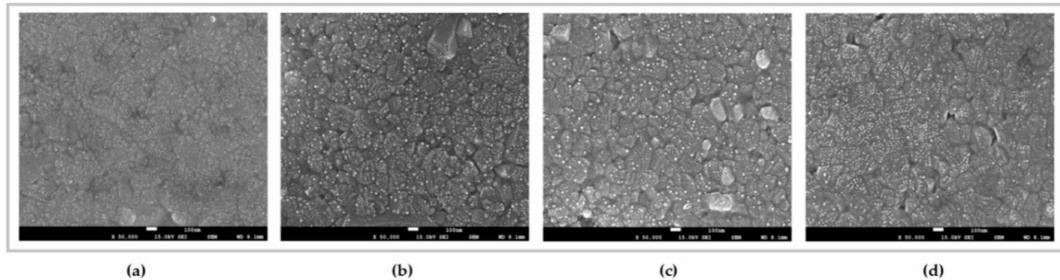
Figure 7. SEM images of the 0.1 wt.% Dy 2 O 3 -doped 0.98BaTiO 3 -0.02(Ba 0.5 Ca 0.5 )SiO 3 specimens sintered at 1320 ◦ C for 1 h with various types of binders: ( a ) binder A, ( b ) binder B, ( c ) binder C, and ( d ) binder D (bar: 100 nm).